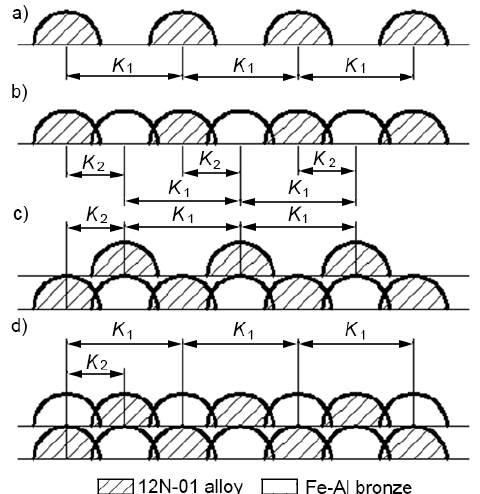
Figure 11 . The scheme of depositing a double composite layer. Figure 11. The scheme of depositing a double composite layer: ( a ) tracks of 12N-01 alloy on the steel substrate; ( b ) single layer of 12N-01 alloy and Fe–Al bronze on the steel substrate; ( c ) tracks of 12N-01 alloy repeated again; ( d ) double layer of 12N-01 alloy and Fe–Al